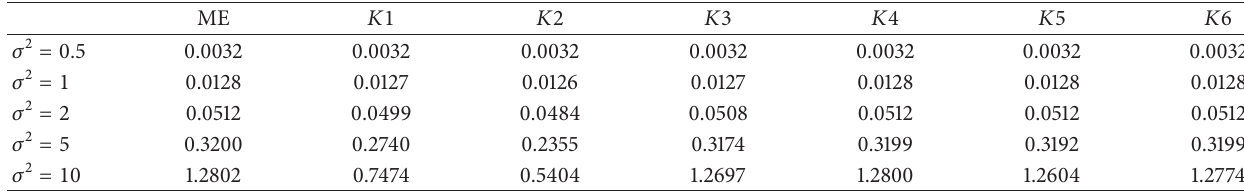
Table 9: Estimated MSE with 𝑛 = 150 , 𝑝 = 4 , and 𝛾 = 0.75 .